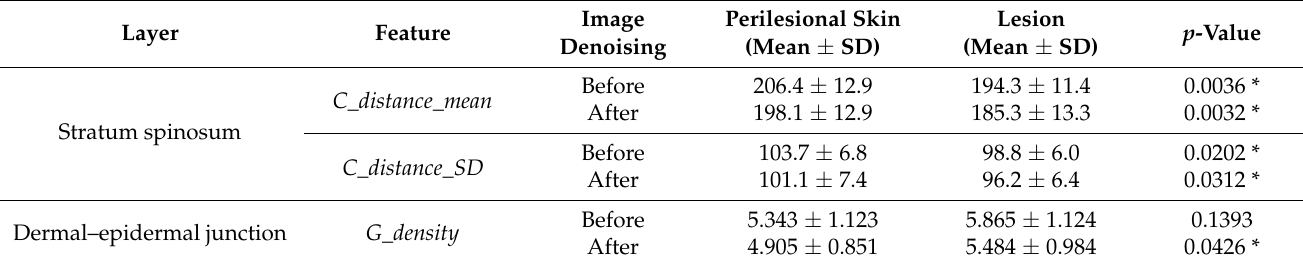
Table 3. The p -values and mean ± SD of the significant features used to identify lesions in the subset without the SC-DnCNN.